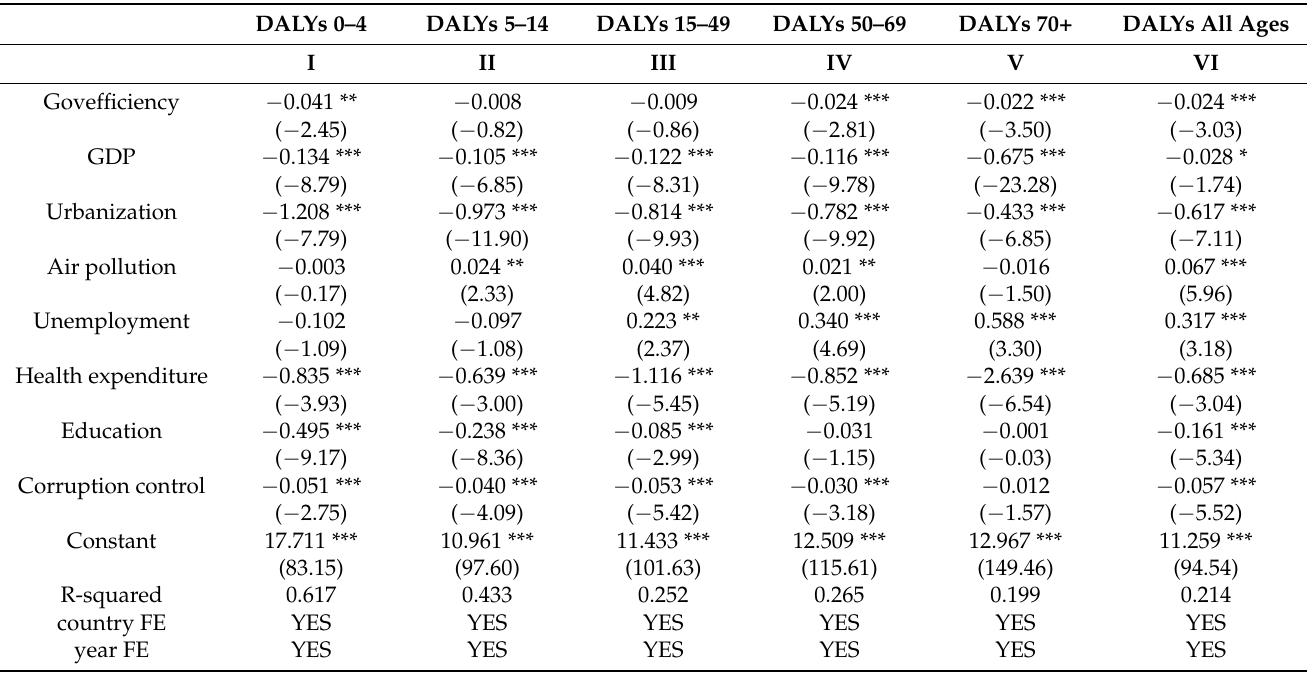
Table 4. Heterogeneity